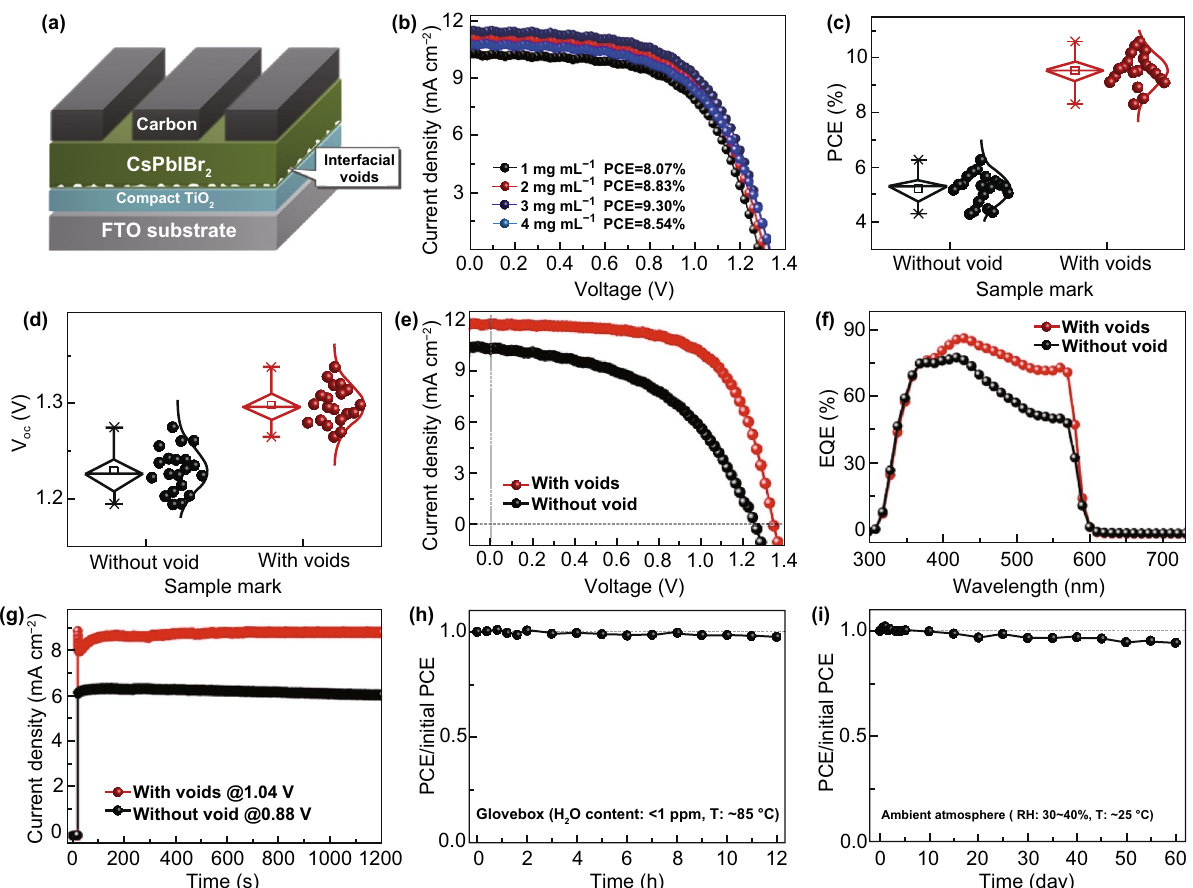
Fig. 4 a Schematic layer stacking of carbon-based, all-inorganic CsPbIBr 2 PSC, b typical J – V curves of the PSCs employed CsPbIBr 2 films prepared with different concentrations of PEAI solutions, c statistic PCEs and d V oc distributions of 20 independent PSCs based on CsPbIBr 2 films without and with interfacial voids, e J – V curves, f EQE spectra, and g steady-state photocurrent outputs of the champion PSCs based on CsPbIBr 2 films without and with interfacial voids. Time-dependent variations of PCEs of the un-encapsulated PSC based on CsPbIBr 2 film with interfacial voids in h glovebox atmosphere and i ambient